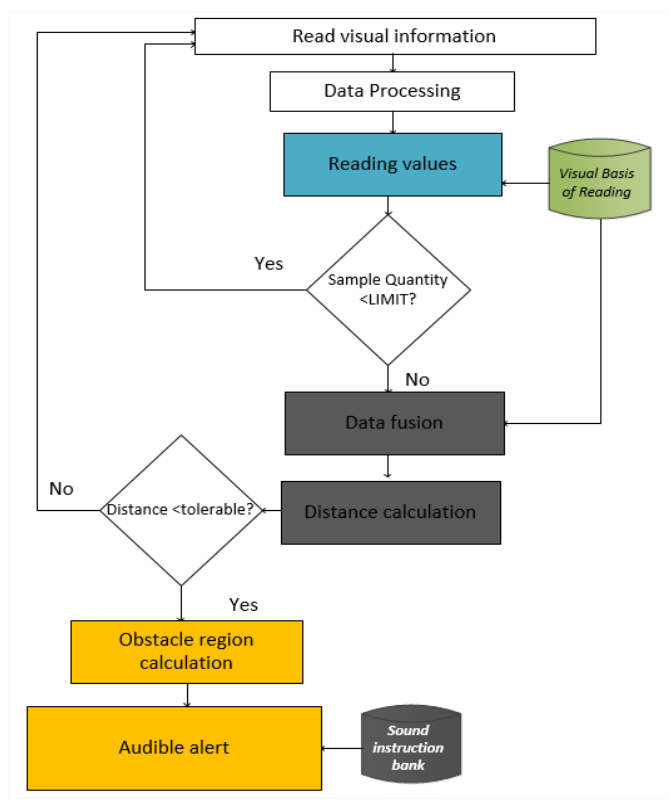
Figure 4. Construction of visual and hybrid information.